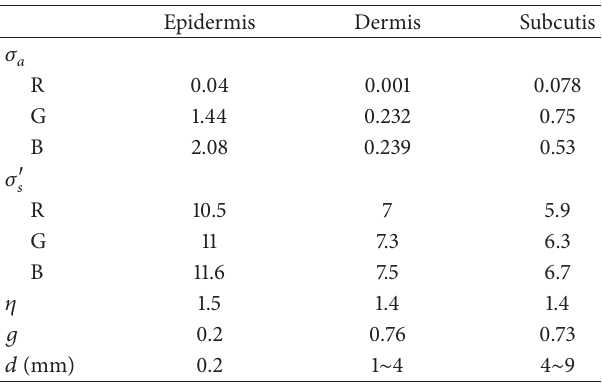
Table 1: Optical parameters for facial